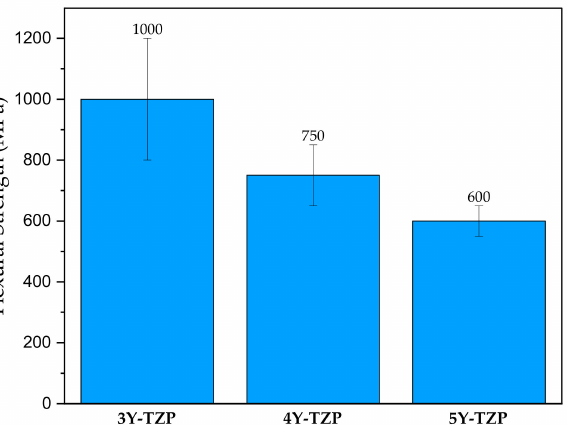
Figure 3. Flexural strength IPS e.max ZirCAD zirconium oxide ceramics varying in yttrium oxide content: 3%-3Y-TZP, 4%-4Y-TZP and 5%-5Y-TZP Adapted from ref.